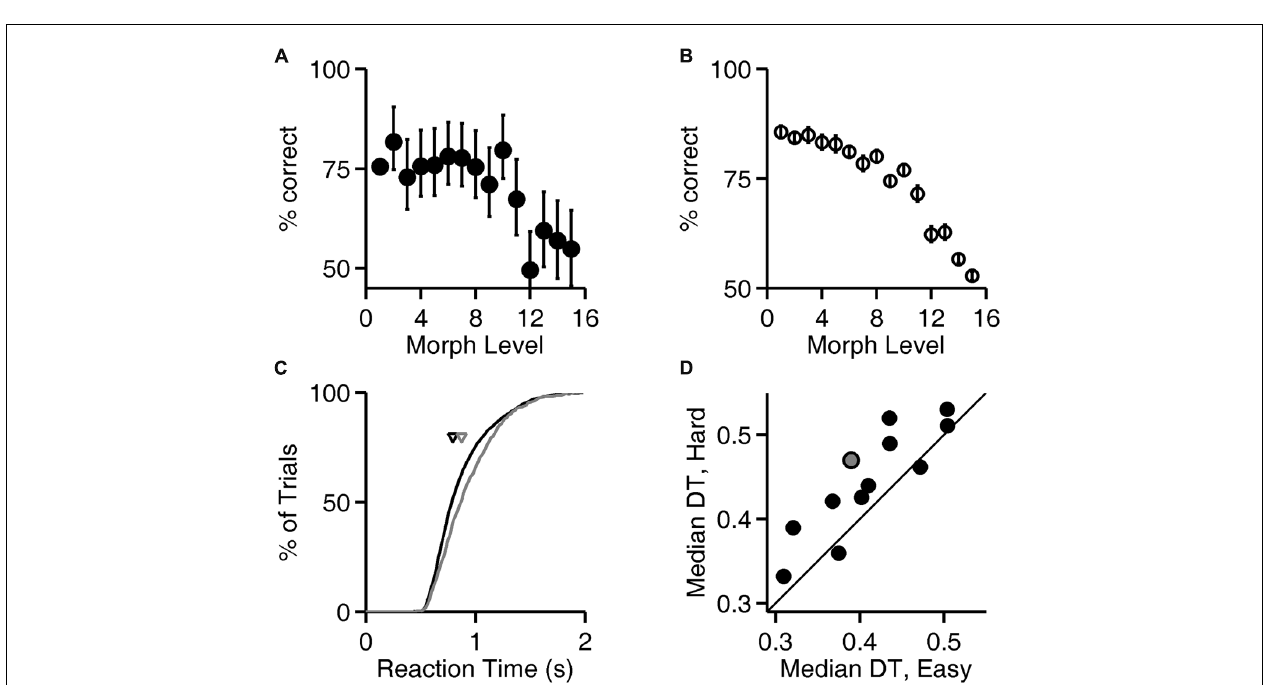
FIGURE 4 | Reaction time increases with trial difficulty. (A) Performance (% correct responses) as a function of stimulus ambiguity (morph level) for one rat (cf. Figures 1D, 2A,B, and 3A ). Error bars show 95% binomial confidence intervals. (B) Average performance of all 12 subjects as a function of the similarity of the two images discriminated. Error bars show SEM over the population of N = 12 subjects. (Data re-analyzed from Clark etal., 2011). (C) Cumulative distribution of reaction time for the subject analyzed in panel (A) , for the easiest (level 1, black curve) and hardest